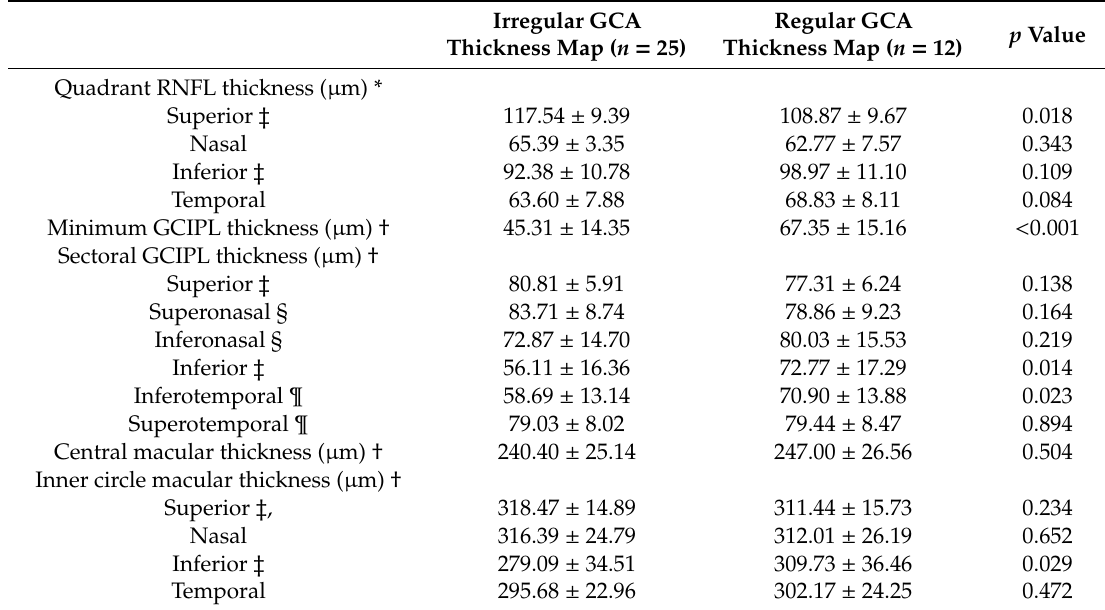
Table 5. Peripapillary RNFL, macular GCIPL, and macular thickness in patients with retinal vein